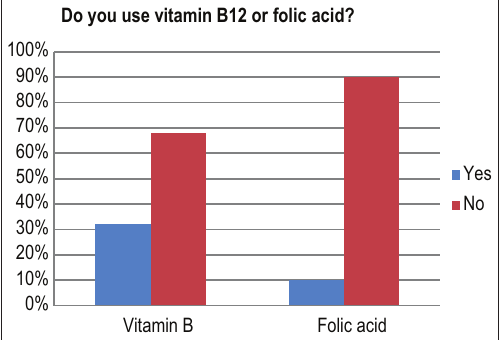
FIGURE 1. Frequency of consuming Vitamin B and folic acid supplements.